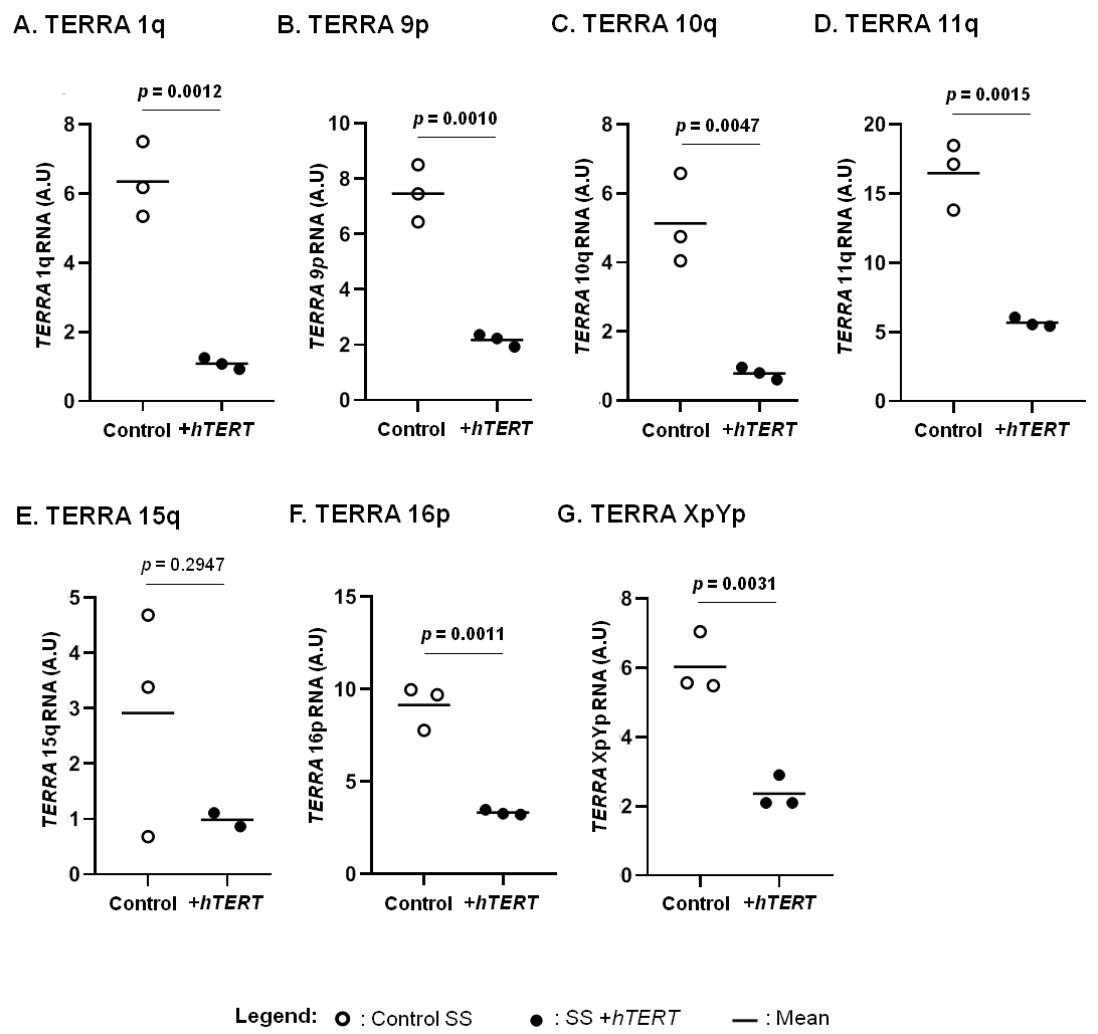
Figure 3. hTERT impact on TERRA transcription. The expression of TERRA from chromosome ends 1q ( A ), 9p ( B ), 10q ( C ), 11q ( D ), 15q ( E ), 16p ( F ) and XpYp ( G ) were analysed in T-MF and SS cells overexpressing hTERT and in their respective controls. Statistical analysis results are displayed on each graph. Significance level: p = 0.05. Data are expressed as mean ± SD.